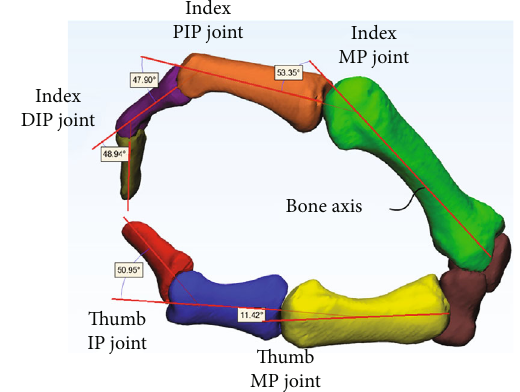
Figure 2: Method for calculating the fl exion angles of the thumb and index fi nger